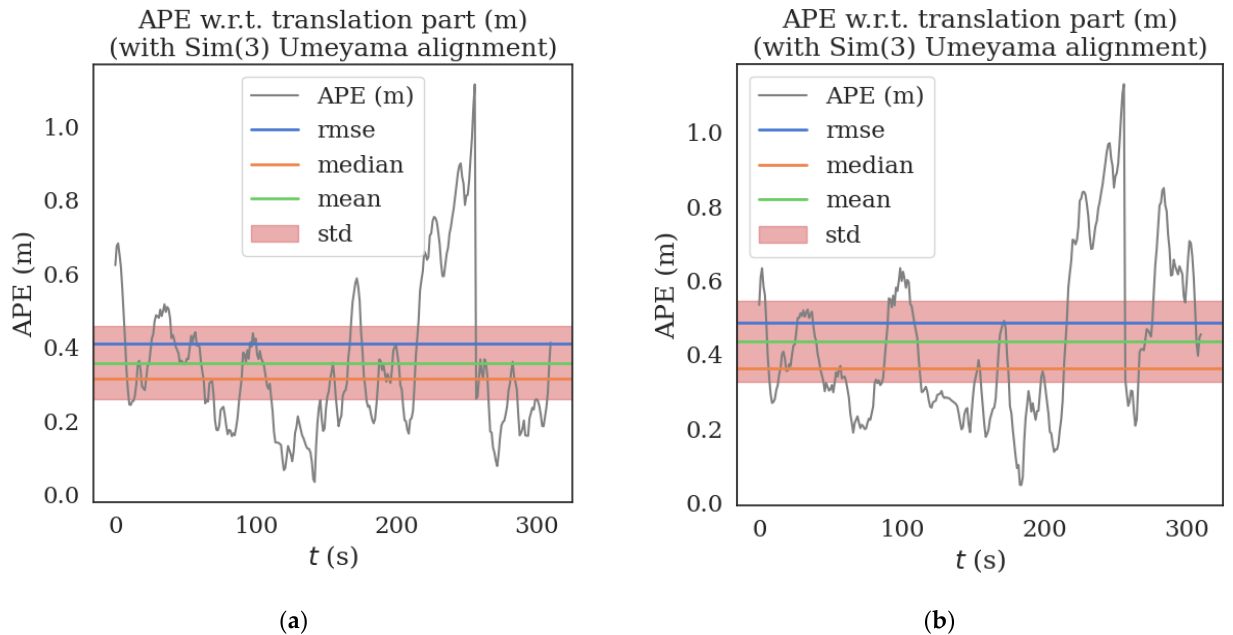
Figure 7. ( a ) is the Absolute Pose Error (APE) of the improved algorithm and ( b ) is the Absolute Pose Error (APE) of the original algorithm. The black line is the absolute pose error (APE), the blue line is the root mean square error (RMSE), the orange line is the median error (median), the green line is the mean error (mean), and the red area is the standard deviation (std).